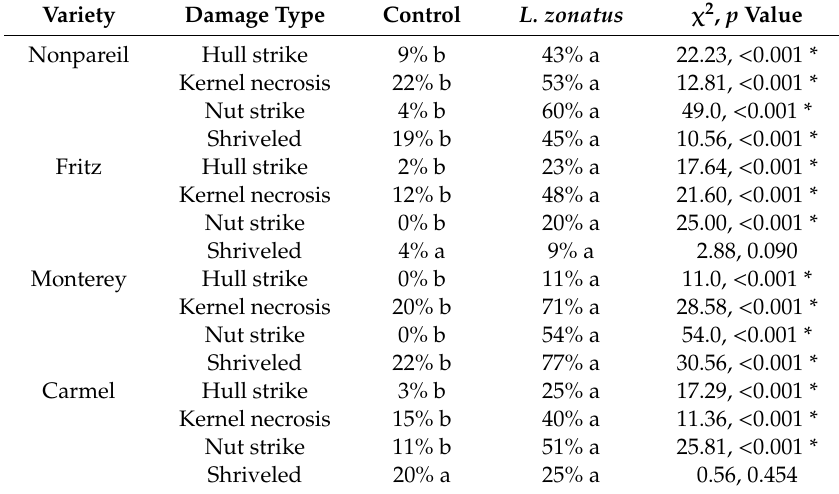
Table 2. Final damage assessment from 2015 of almonds in four varieties following three di ff erent